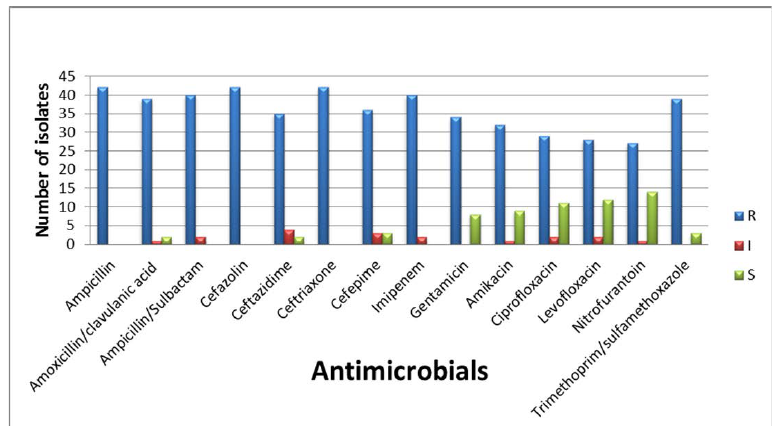
Fig. 1. The Antibiogram pattern of isolates towards antimicrobials used in this study. (R): Resistant, (I): Intermediate and (S): Table 1. The primers used in this study Gene Primer Sequence (5' - 3' ) Product